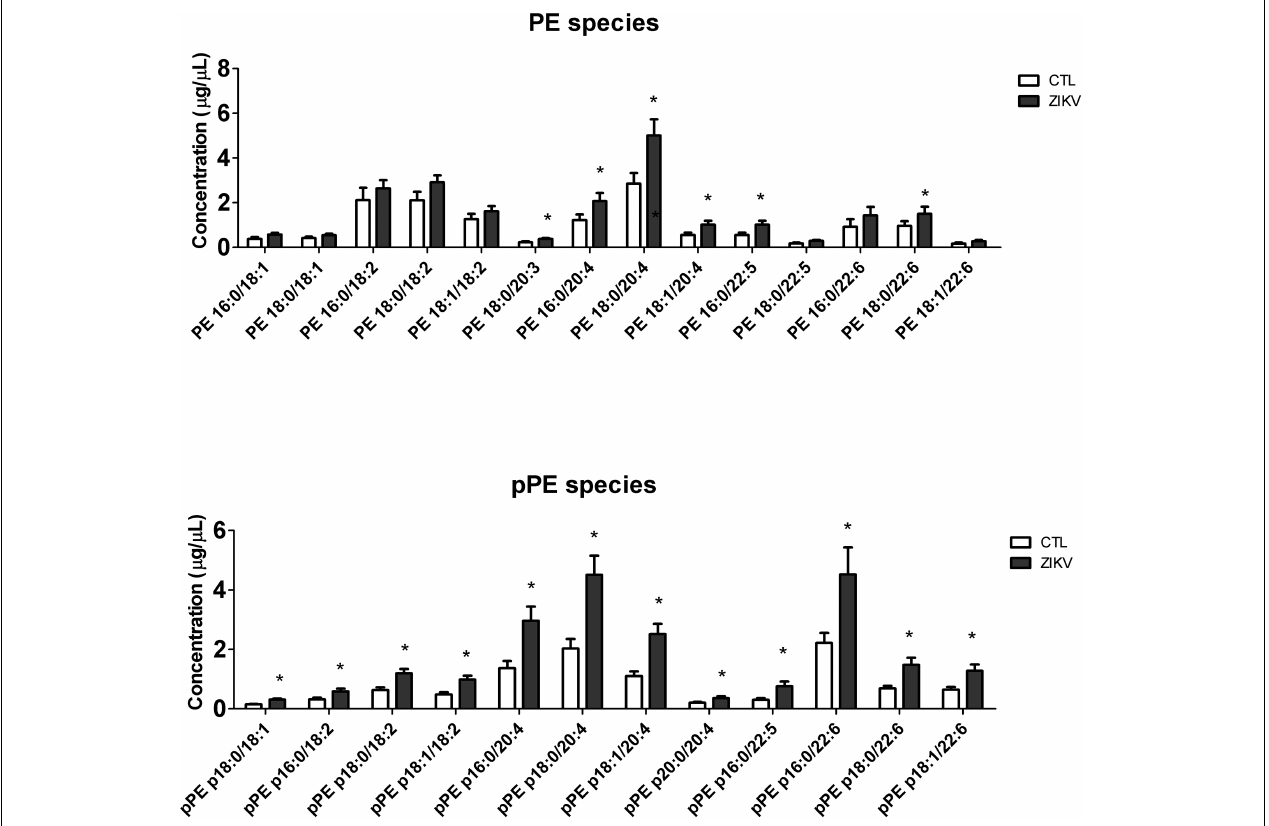
FIGURE 3 | Serum concentration of molecular species of PE and pPE in ZIKV infected (ZKV) and controls (CTL) patients. Concentration values are given in µ g lipid/ µ L of serum and data represented as mean ± standard error ( n = 12 for each group). Comparison between the groups was performed using t -test ( p -value < 0.05) and significantly altered species are marked with ∗ . Identified lipid species were annotated by a shorthand nomenclature corresponding to the level of detail attainable by the analysis (e.g., PE 16:0/20:4). The symbol “/” denotes constituting fatty acids moieties of the lipid species, and not their sn-1 and sn-2 position on the